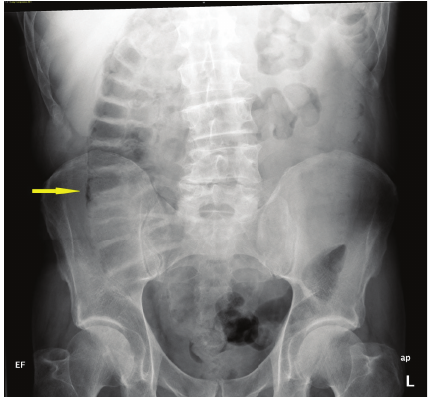
Figure 1: An abdominal X-ray showing pneumatosis intestinalis in the ascending colon of Patient 1.